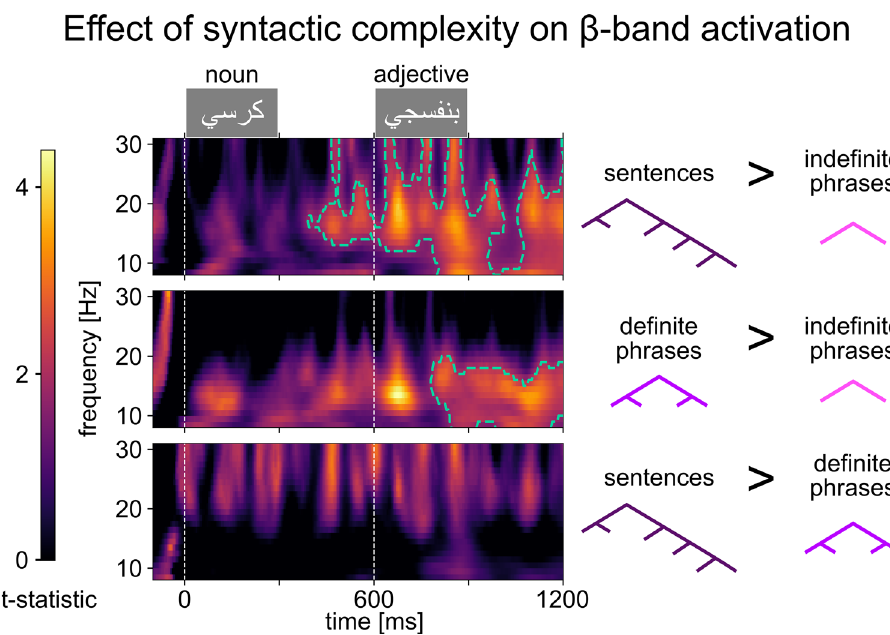
Figure 4. Pairwise comparisons of time–frequency representations of increased activity in two-word trials compared to baseline. Color bar shows t statistic values. White dashed lines represent word onsets. Green dashed lines delineate suprathreshold clusters which survive the permutation